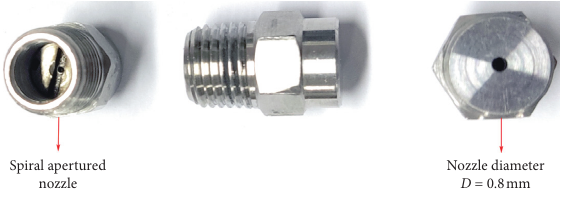
Figure 3: Structure of the spiral-apertured pressure